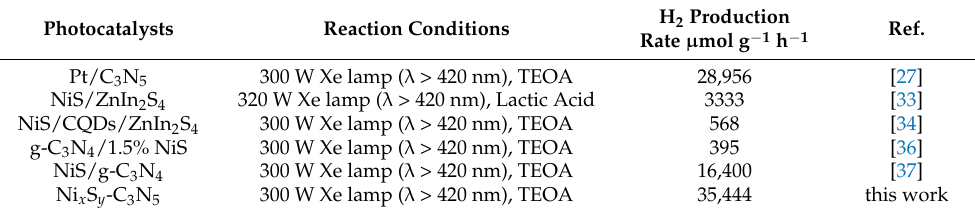
Table 1. The comparison of the photocatalytic H 2 production performance of the Ni x S y -C 3 N 5 with some reported